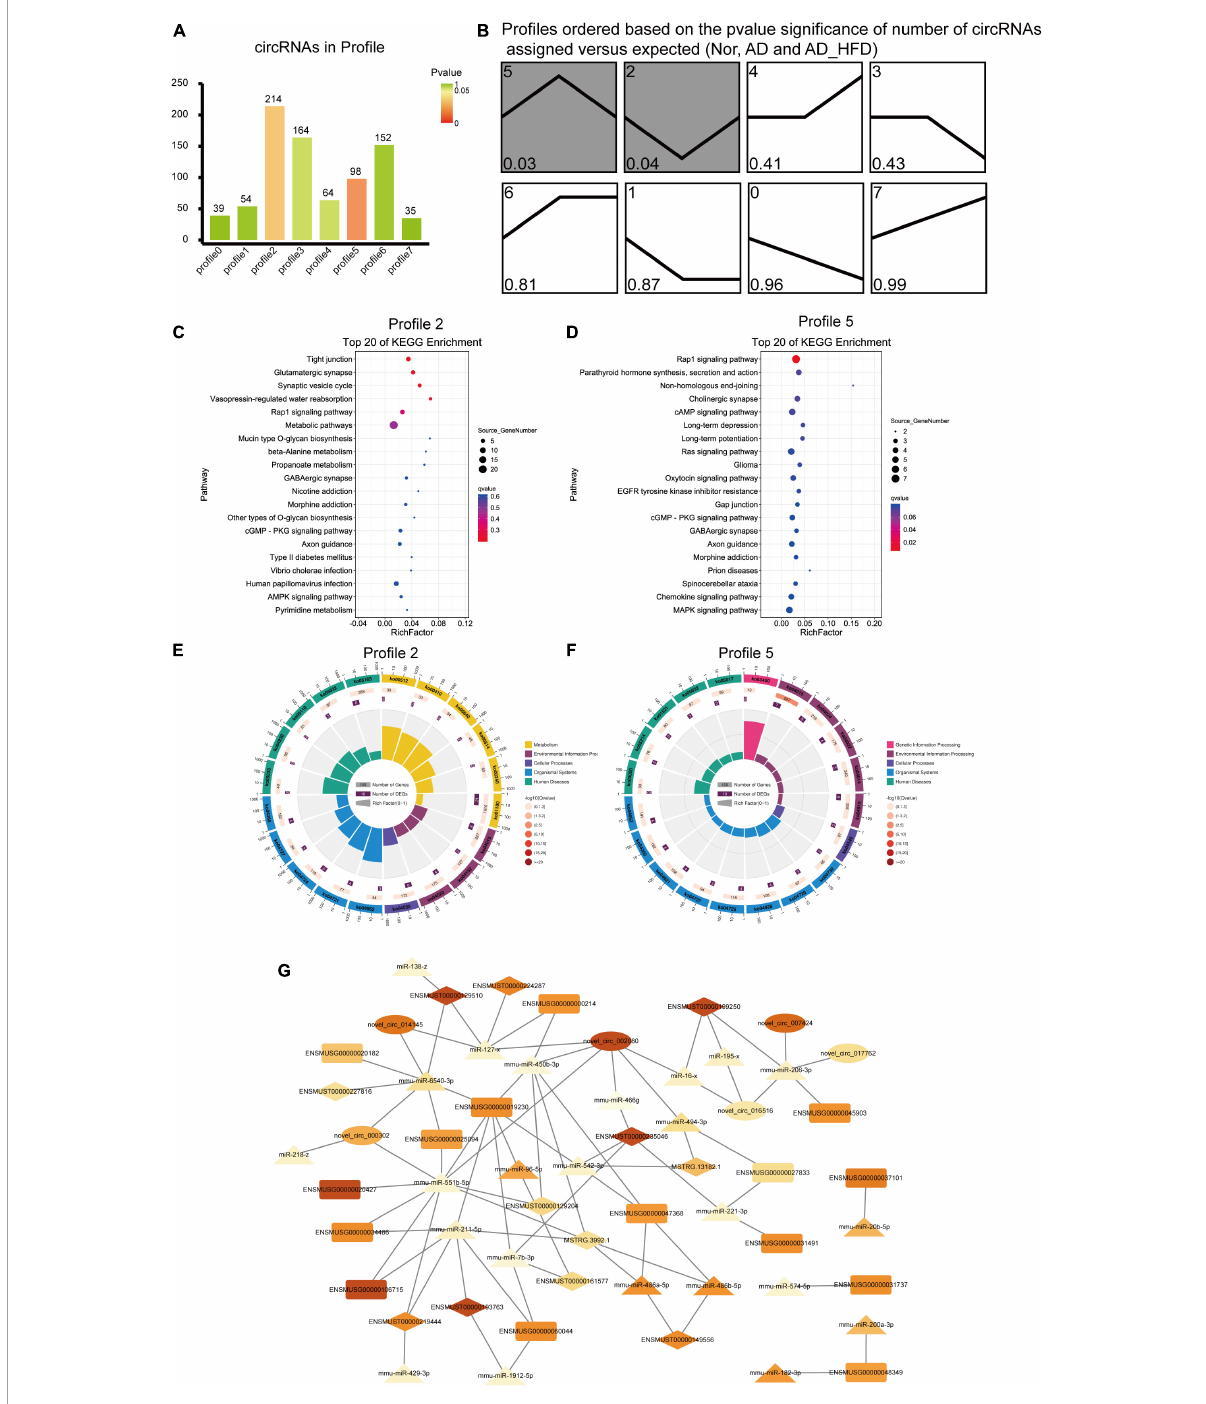
FIGURE6 Trend analysis of circRNAs and ceRNA network. (A) The number of circRNAs in profile. Green represents P -value which is closed to 1 and red represents the P -value is closed to 0. (B) Trends analysis of circRNAs among the Nor, AD and AD_HFD groups. Pathways enriched by genes regulated by differentially expressed circRNAs in profile 2 (C) and profile 5 (D) . The enrichment circle diagrams of GO enrichment analysis in profile 2 (E) and profile 5 (F) . The first circle: enrichment of the first 20 GO term. Different colors represent different ontologies; the second circle: the number and Q -value of the GO term in each classification gene background. The more the number of gene background in each classification, the longer the bar, and the smaller the Q -value, the redder the color. The third circle: the number of genes in each category of the GO term; fourth circle: RichFactor value of each GO term. (G) The Competing Endogenous RNA Network. Rectangle indicates mRNA, ellipse indicates circRNA, and prism indicates lncRNA, triangle indicates miRNA. The larger the FC value, the darker the